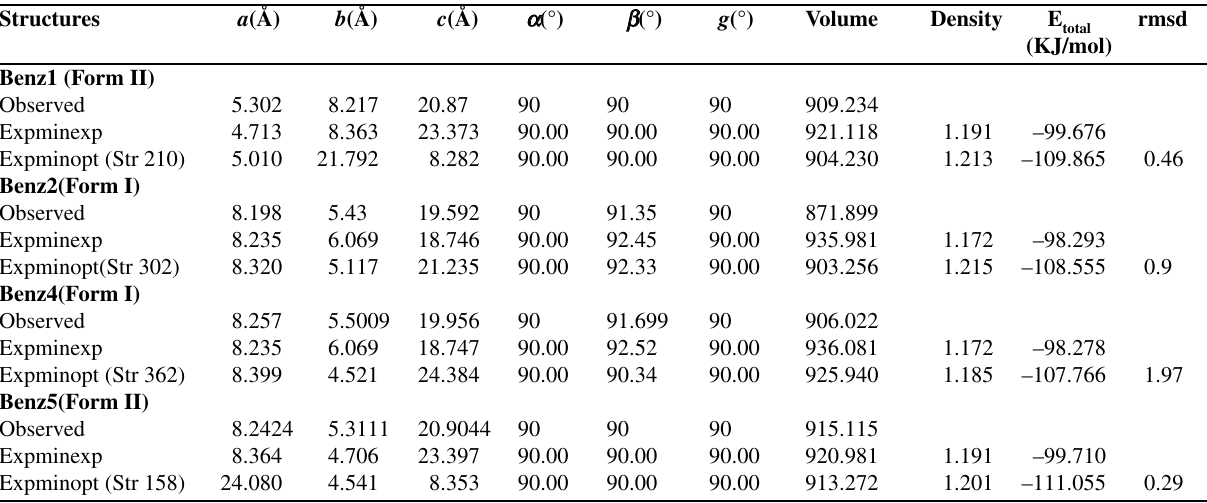
Fig. 4. Energy landscape consisting the possible conformers of benzocaine associating the E Table 2. Regeneration of the crystal structures of Benzocaine molecule using the experimental data, minimized experimental conformation (Exp- minexp) and the matching structures (20 molecules in common) found during the search of conformers. Structures